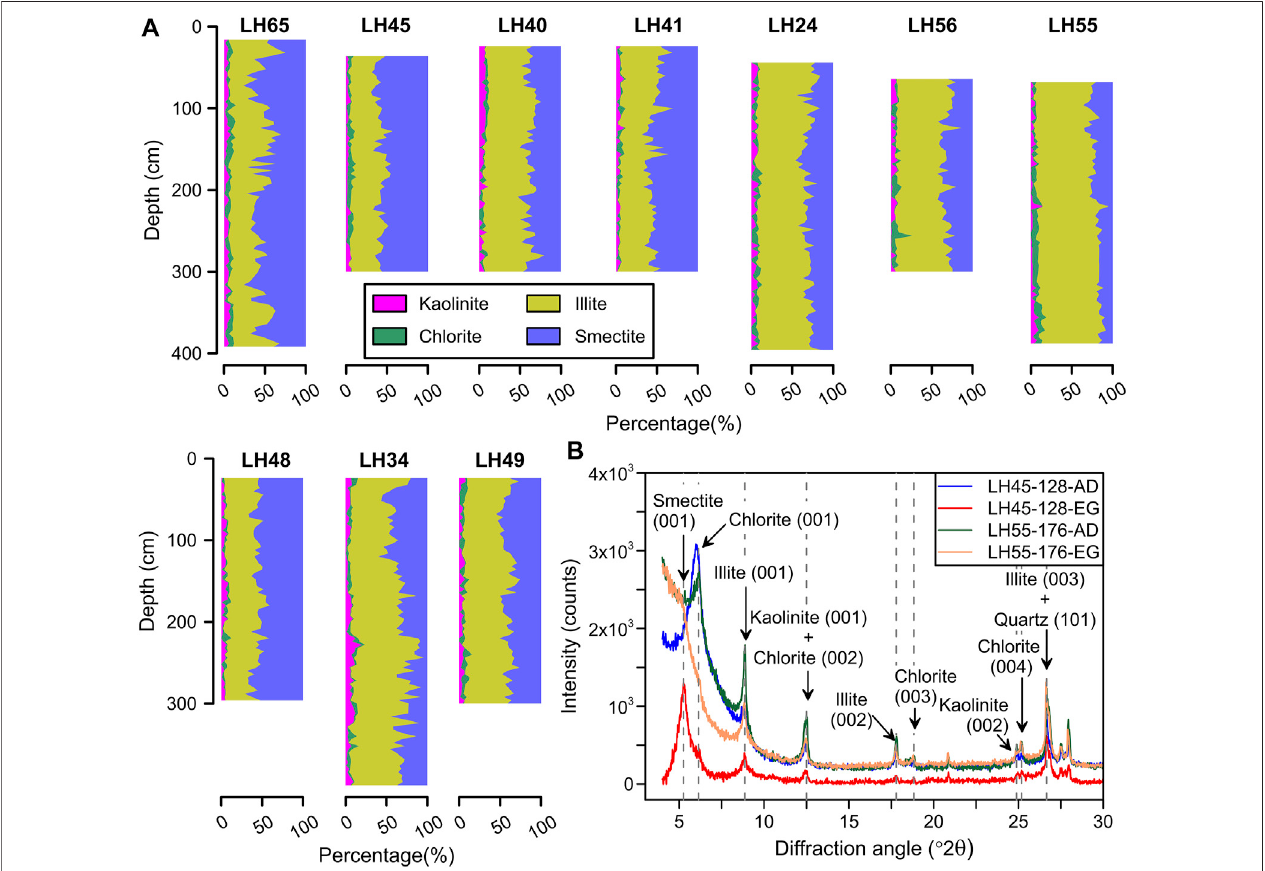
FIGURE 4 | (A) Relative content of the four clay minerals: kaolinite, chlorite, illite, and smectite in the core sediments. (B) Glycolate curves for two representative samples LH45-128 and LH55-176.